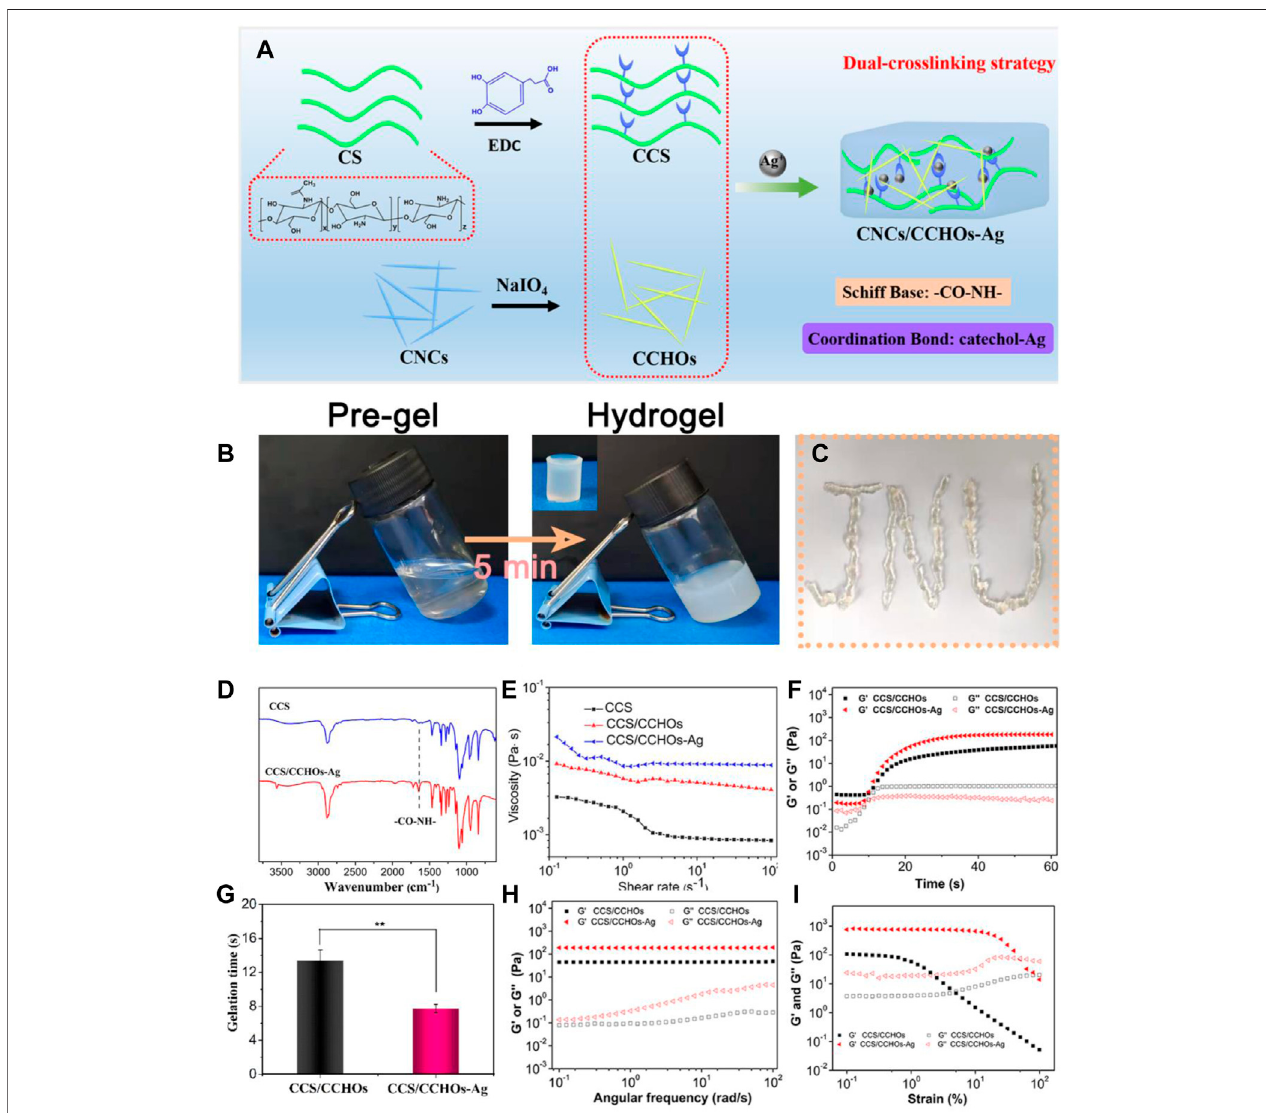
FIGURE2| (A) Scheme ofCCS/CHO-Aghydrogel synthesis byadual-cross-linkingstrategy. (B) Optical images ofhydrogels via atube inverted test. (C) Injection processoftheresultanthydrogel. (D) FTIRspectra showed theformationoftheCCS/CHO-Aghydrogel. Therheologicalresults ofobtainedhydrogels: (E) Viscosityand viscoelasticityofCCS,CCS/CCHOs, andCCS/CCHO-Agwhiskeraqueoussuspensions; (F) timesweepingofstoragemodulus( G ′ )andlossmodulus( G ″ ); (G) gelation time obtained by time sweeping test; (H) frequency-dependent (at a strain of 1%) and (I) strain-dependent ( ω = 6.28 rad/s) oscillatory